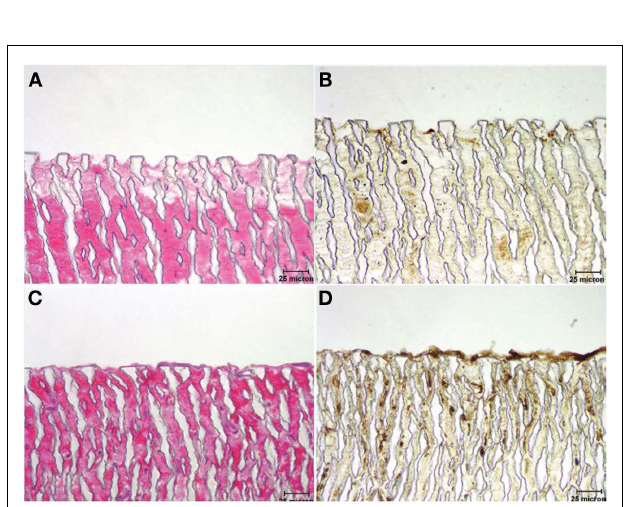
FIGURE 2 | Micrographs illustrating the luminal surface of grafts stained with hematoxylin and eosin [H&E (A,C)] and horseradish Griffonia simplicifolia (Gs-1) lectin (B,D), which exhibits specificity to endothelial cells . (A,B) Control graft – note absence of a cellular lining; (C,D) laminin type 1-treated graft exhibiting a cellular lining that reacted actively with Gs-1 (Williams et al., 2011). Copyright ©2011Wiley Periodicals,